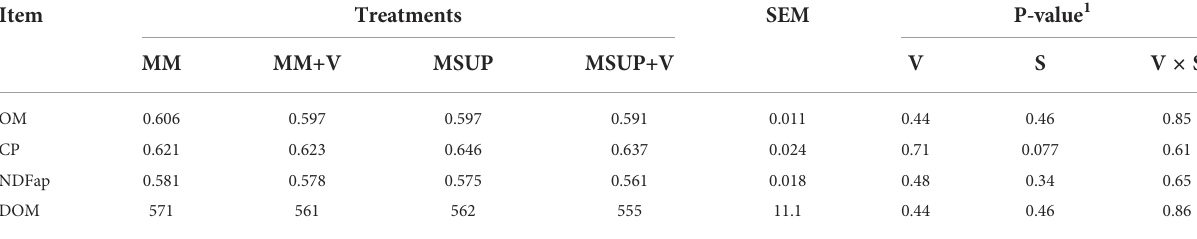
TABLE 4 Effects of feeding multiple supplement and, or virginiamycin on total digestibility (g/g) and total dietary content of digested organic matter (g/kg dry matter) in Brahman heifers fed a high-quality tropical